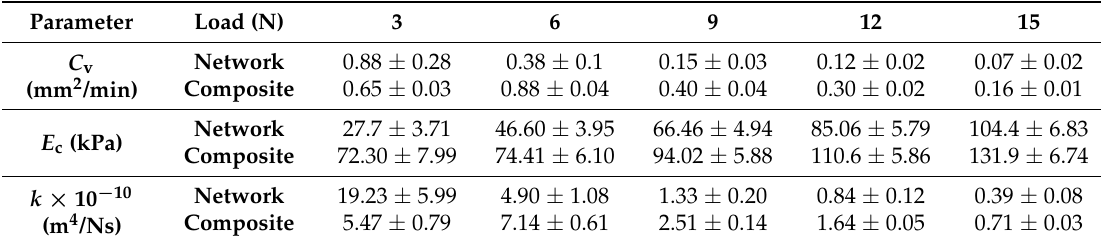
Figure 5. ( A ) Changes in the scaffold hydraulic permeability ( k ) with increase in load; ( B ) ε v during loading are plotted to distinguish the rate of consolidation in network and composite scaffolds. Unloaded data points are also shown on the same figure.